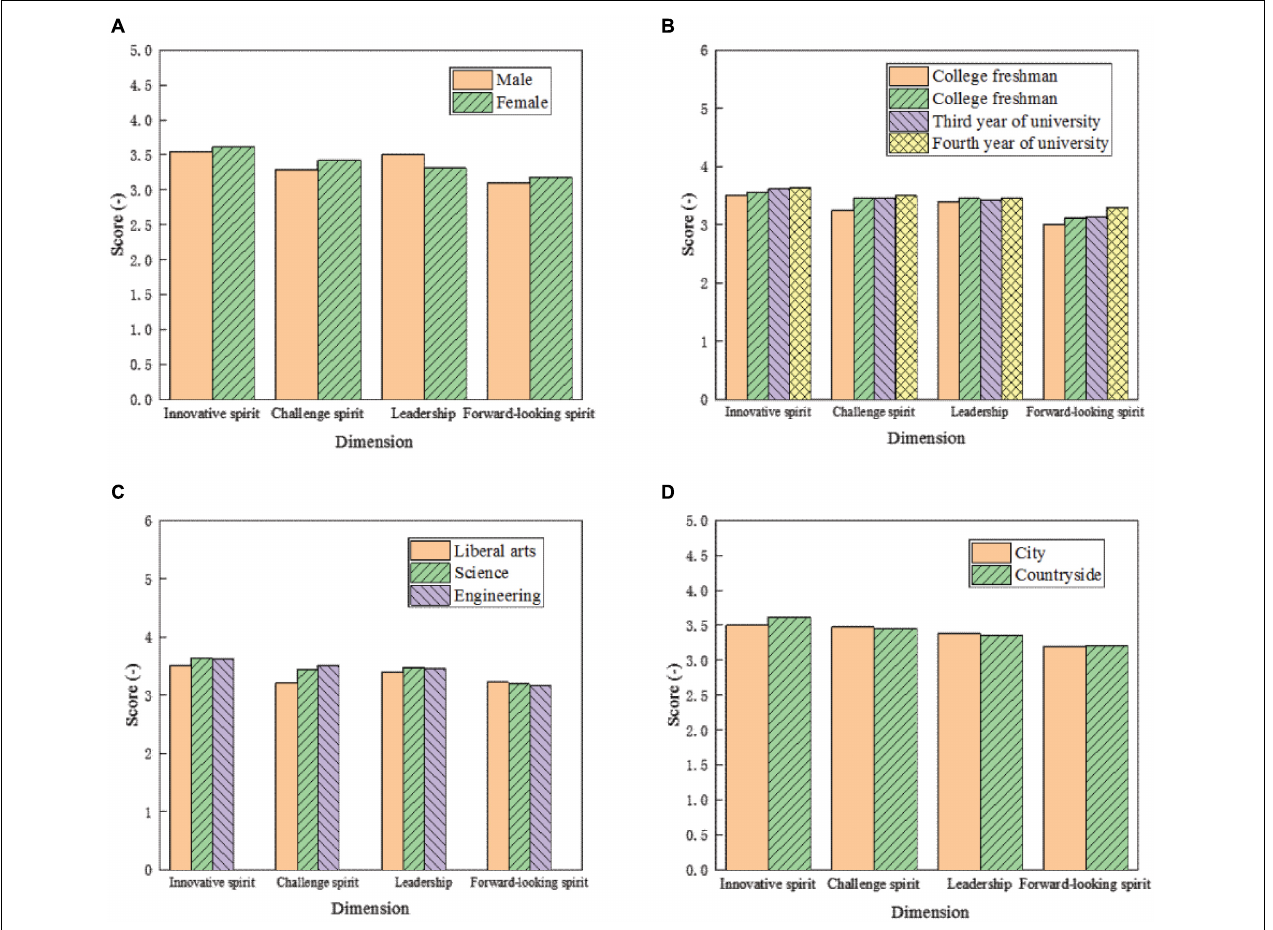
FIGURE 6 | Scores of entrepreneurship of different students. The scores of entrepreneurship of students with different (A) genders, (B) grades, (C) subjects, and (D) family situations are